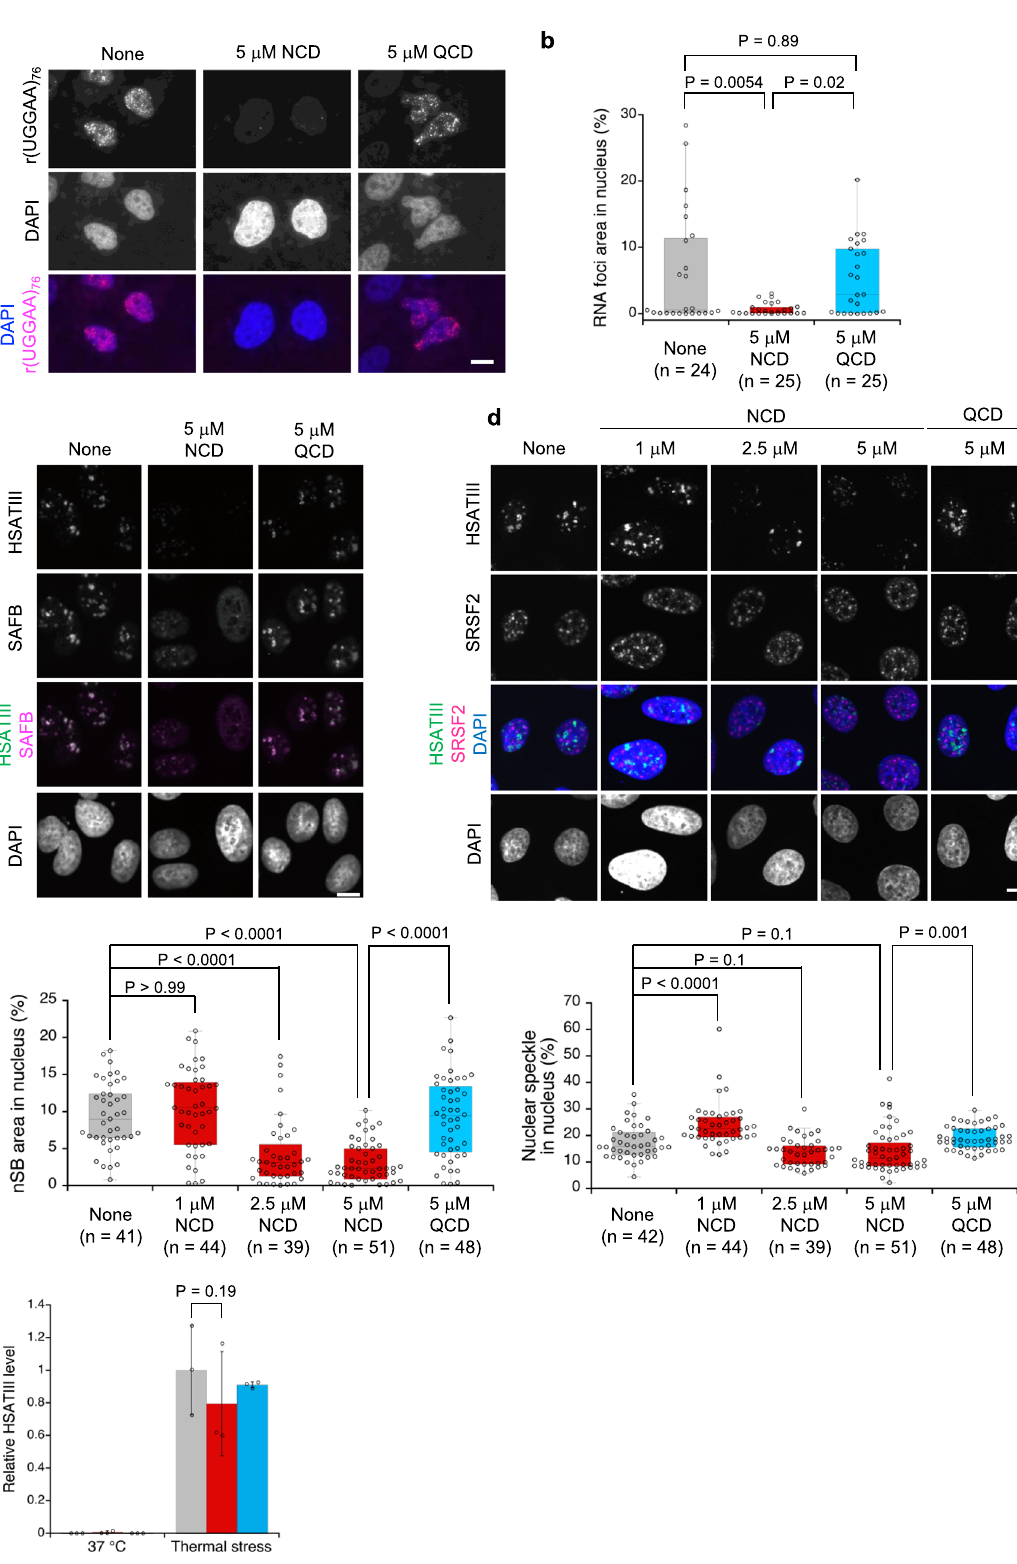
One of the common structural characteristics observed for the toxic RNAs is the formation of hairpin structures involving multiple mismatched base pairs 49 . The expanded r(UGGAA) n repeat RNA, causing SCA31 likely takes various secondary and tertiary structures, and these structures are under the